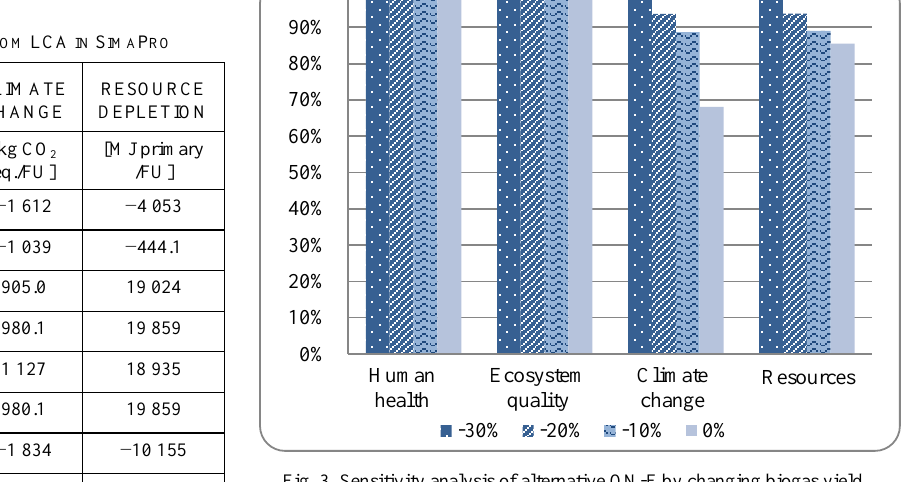
Fig. 3. Sensitivity analysis of alternative ON-F by changing biogas